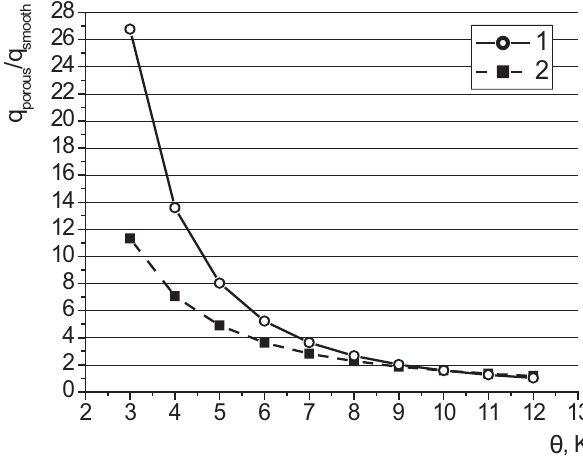
Figure 10. Enhancement ratio for distilled water boiling (3K < q < 12K); 1 – metal-fibrous microstructure of 81% porosity, 2 – metal-fibrous microstructure of 67% porosity Table 2. Comparison of the experimental and selected literature data for the sample of highest porosity Data from literature: Experimental data: Wójcik (2009) Boiling 81% porosity, 85% porosity, liquid 0.9 mm height 0.8 mm